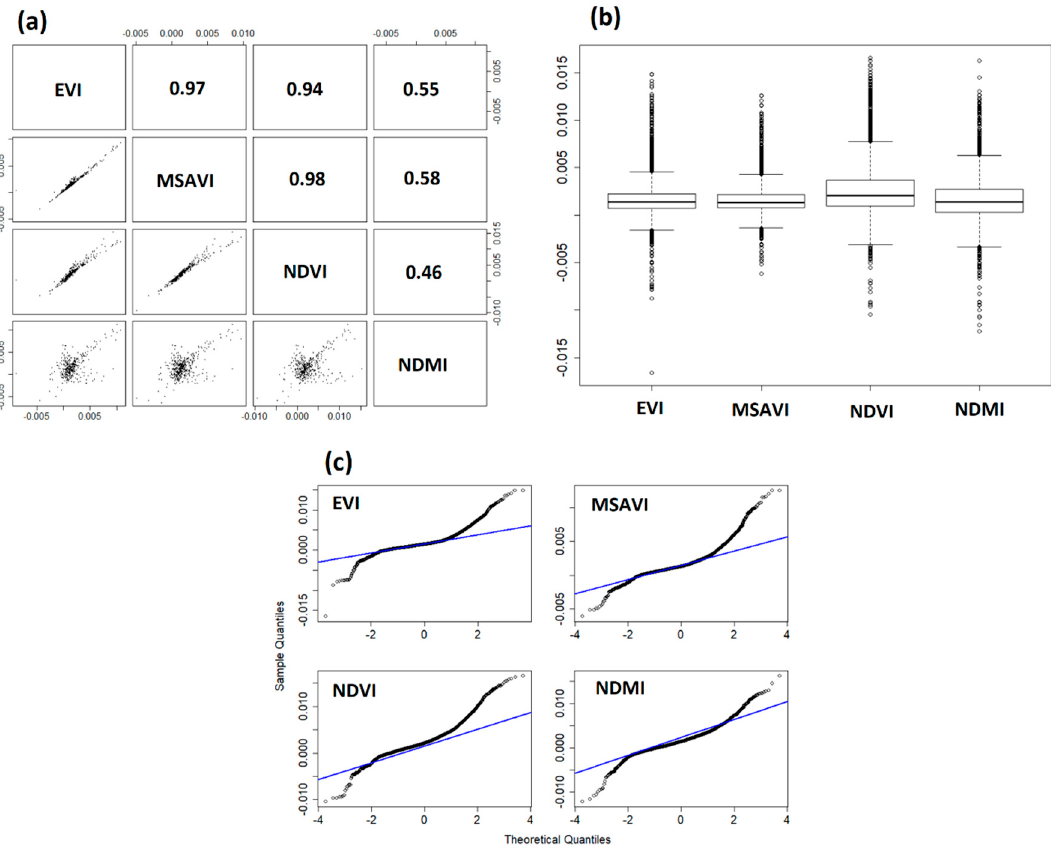
Figure 6. Pair wise scatter plots ( a) , boxplot ( b ), and QQ (quantile-quantile) plots ( c ) showing the correlation and statistical distribution of trend slopes derived from EVI, MSAVI, NDVI, and NDMI.